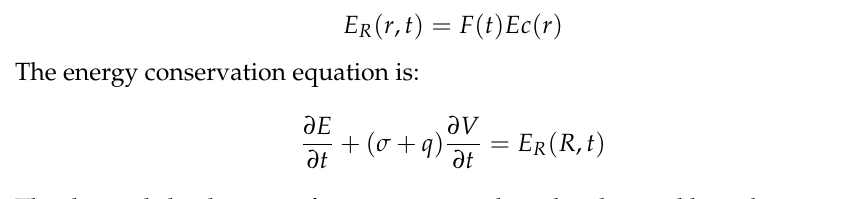
Figure 12. Energy deposition rates of different energy electrons in multilayer structures.